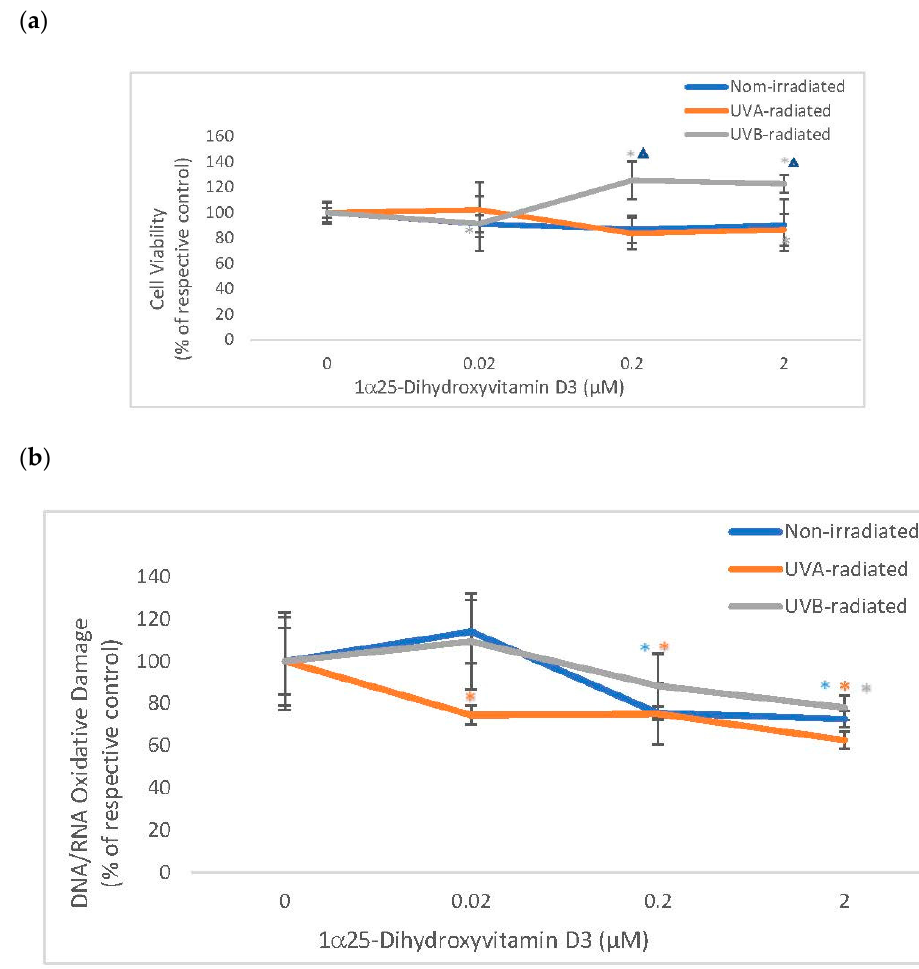
Figure 4. The effect of 1 α , 25dihydroxyvitamin D3 (vitamin D) on Cell Viability and Oxidative DNA / RNA Damage in non-irradiated, UVA-radiated, and UVB-radiated fibroblasts. Non-irradiated (blue), UVA-radiated (orange), or UVB-radiated (grey) fibroblasts were incubated with vitamin D (0–2 µ M) and examined for cell viability by MTS assay (Promega) ( a ), and for DNA / RNA oxidative DNA damage by competitive ELISA (Cayman Chemical) ( b ). * = p < 0.05, relative to respective controls. ∆ = p < 0.05, between non-irradiated and UVB radiated cells. Error bars represent standard deviation, n = 4.